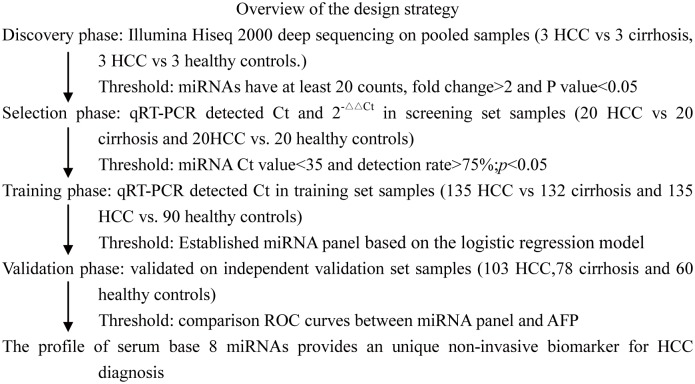
A flow-chart of the experimental design.